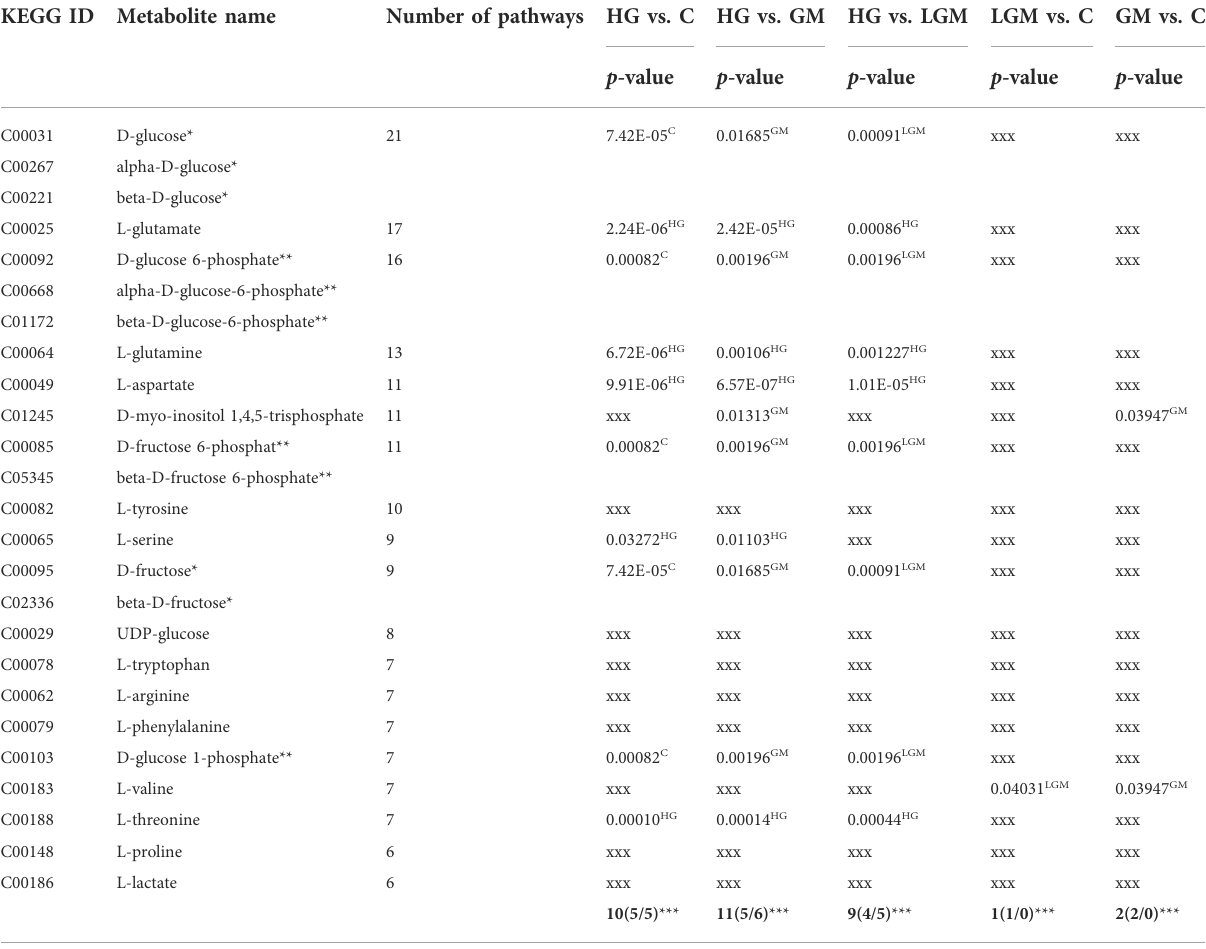
TABLE 3 Overview of the most commonly found hub metabolites in the pathway enrichment analyses, with p-values of the different comparisons; ranked by the number of occurrences in pathways, superscripts indicate signi fi cant upregulation in the corresponding treatments, epimers are summed up, “ xxx ” no signi fi cant differences in this comparison. KEGG ID Metabolite